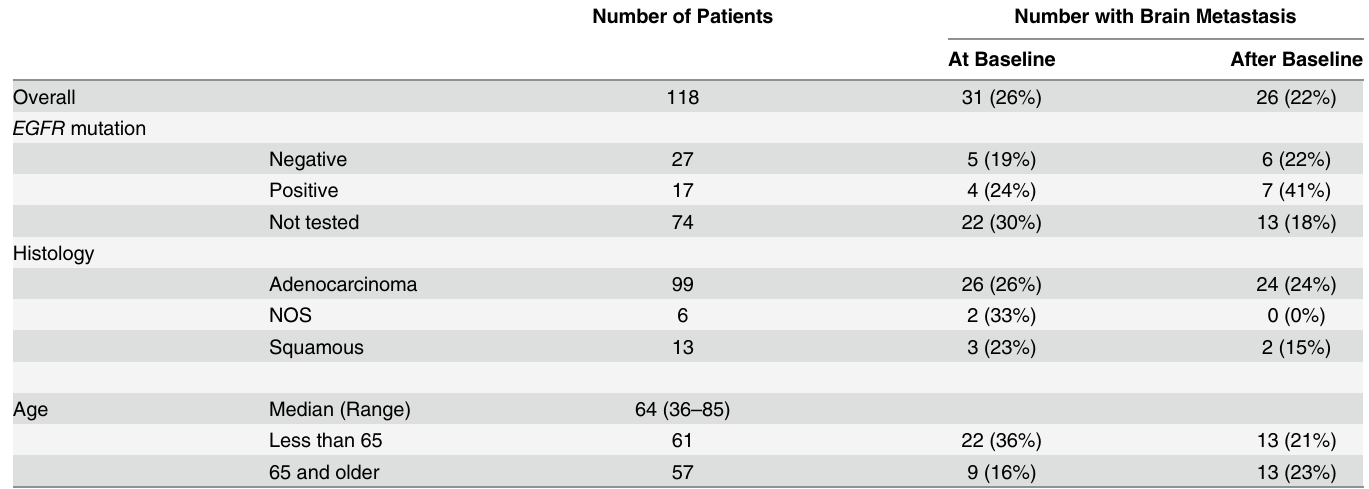
Table 1. Distribution of clinical factors by presence of brain metastases at baseline or development of subsequent brain metastases after baseline.